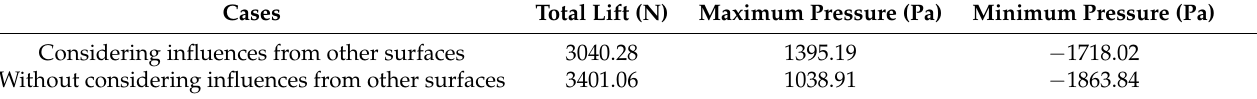
Table 3. Comparison of aerodynamic results of the stabilizer regarding the influence from other lifting surfaces.